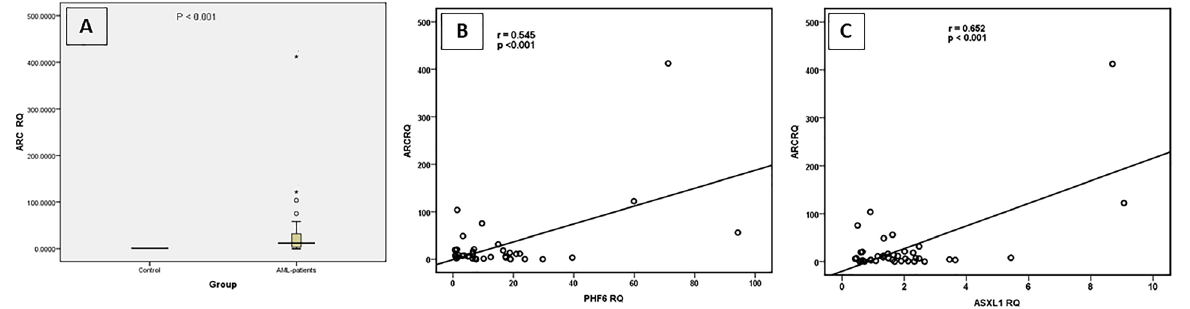
Figure 3 - Significance of ARC expression. ARC expression levels, represented as RQ value, in AML patients and in Control groups (A). Correlation between ARC expression and PHF6 expression (B). Correlation between ARC expression and ASXL1 expression